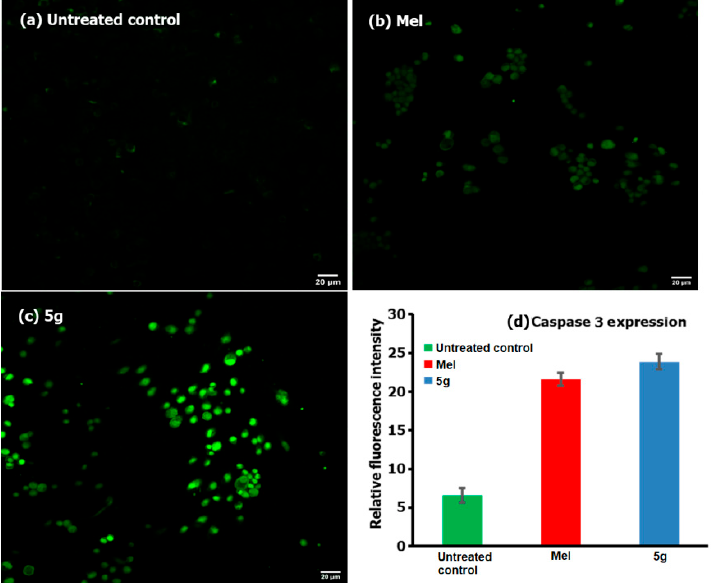
Figure 6. Caspase-3 activity of HepG2 cells when treated against the testing compound 5g ( c ) and the positive control of Mel ( b ). The cells without any treatment were taken as the negative control ( a ), and the relative fluorescence intensities are shown in ( d ).